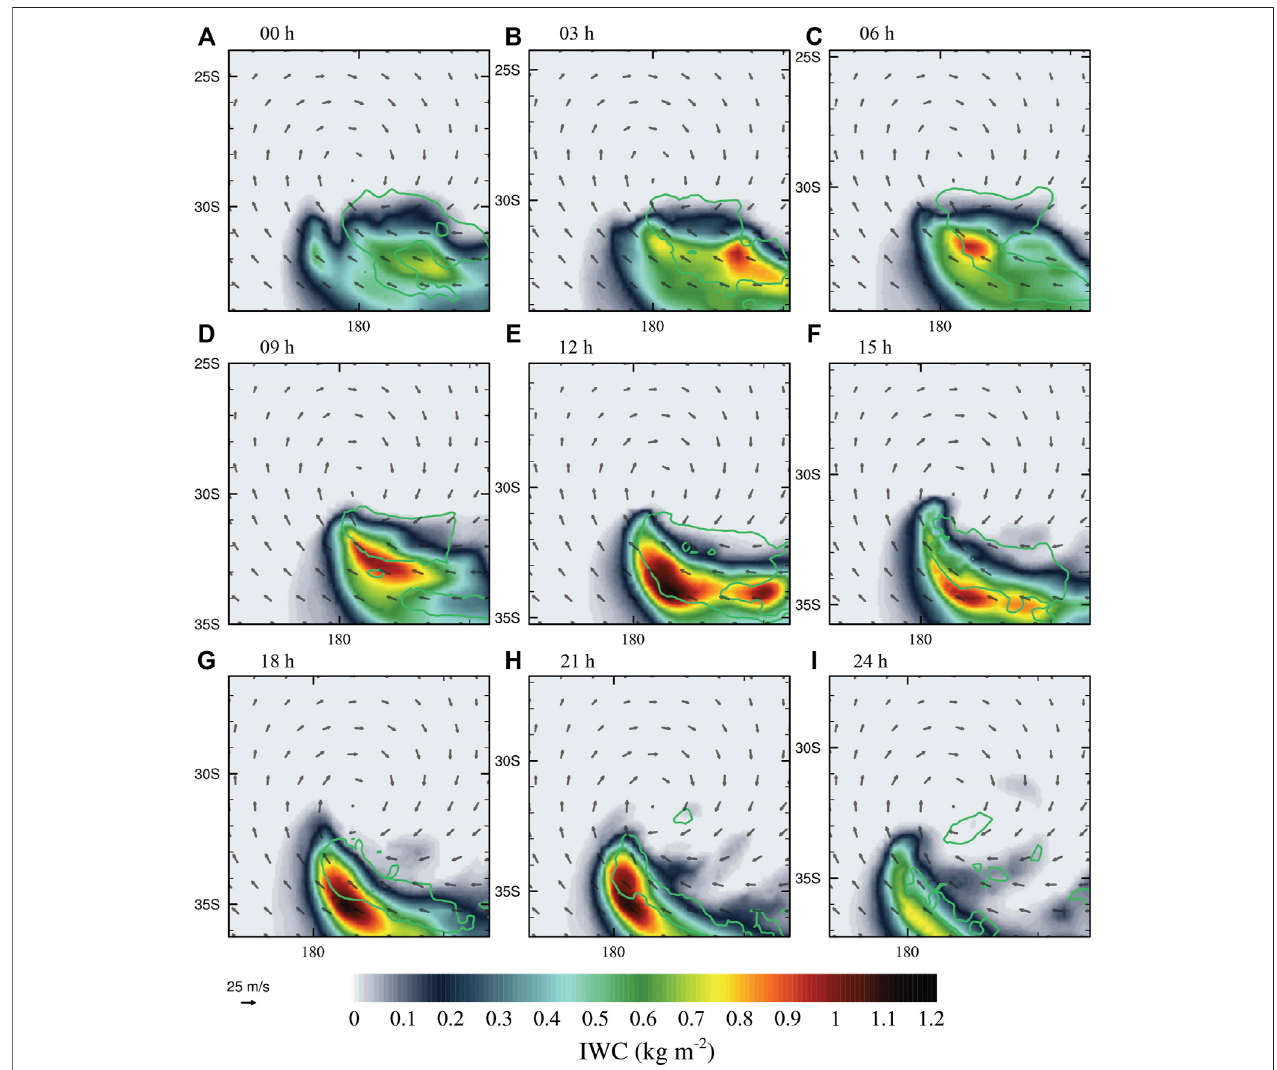
FIGURE 3 | Total column liquid (green lines at 0.4 kgm − 2 ) and ice water content (shading) of ERA5 on January 15, 2022. The UTC time is on each panel from A – I . The TC center is at the center of each panel.